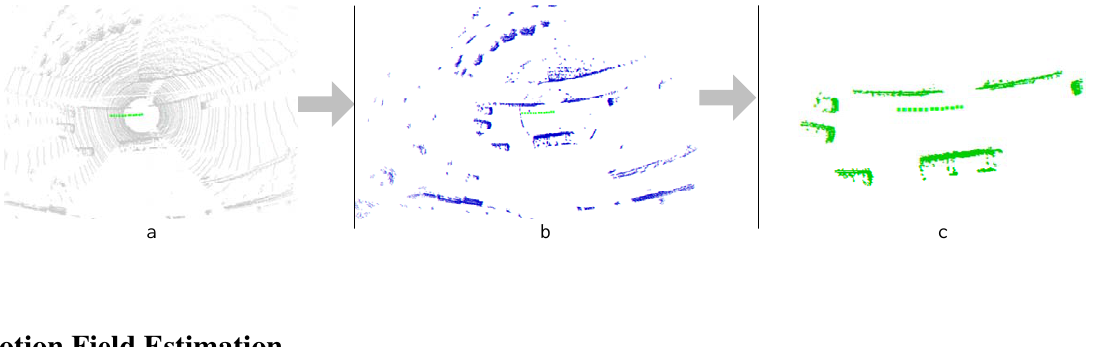
Figure 4. Detection of potential moving measurements. The green line is the ego-trajectory. ( a ) The raw measurements; ( b ) the non-ground measurements; ( c ) the potential moving